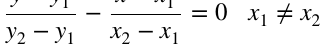
Fig. 11 A schematic illustration of the centerline of an iron tube